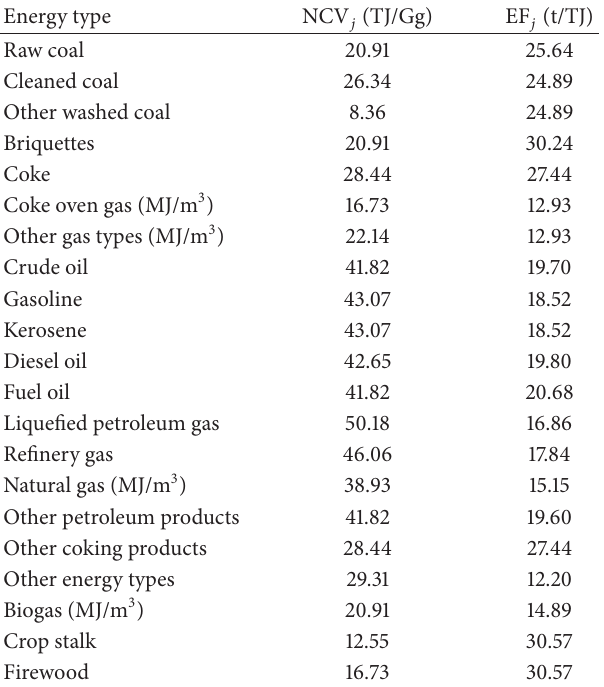
Table 2: Net calorific values and default carbon emission factors of the considered energy